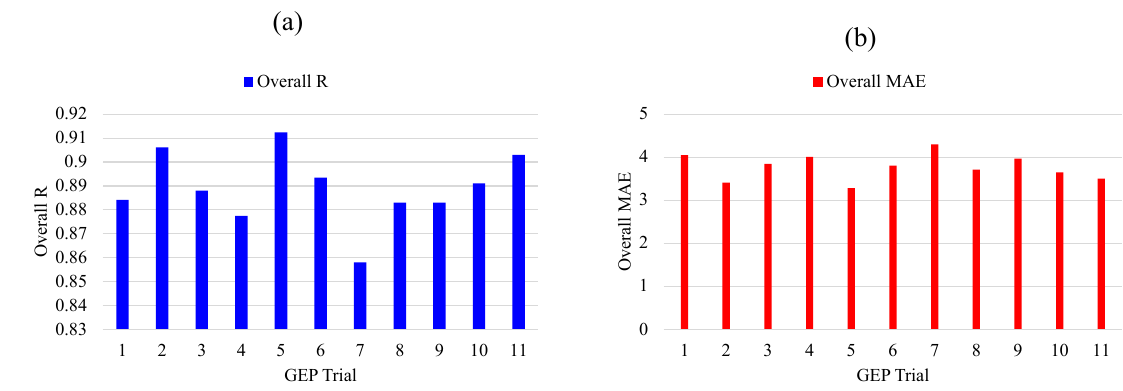
Figure 4. Comparison of overall ( a ) R and ( b ) MAE for the trials undertaken in this study.